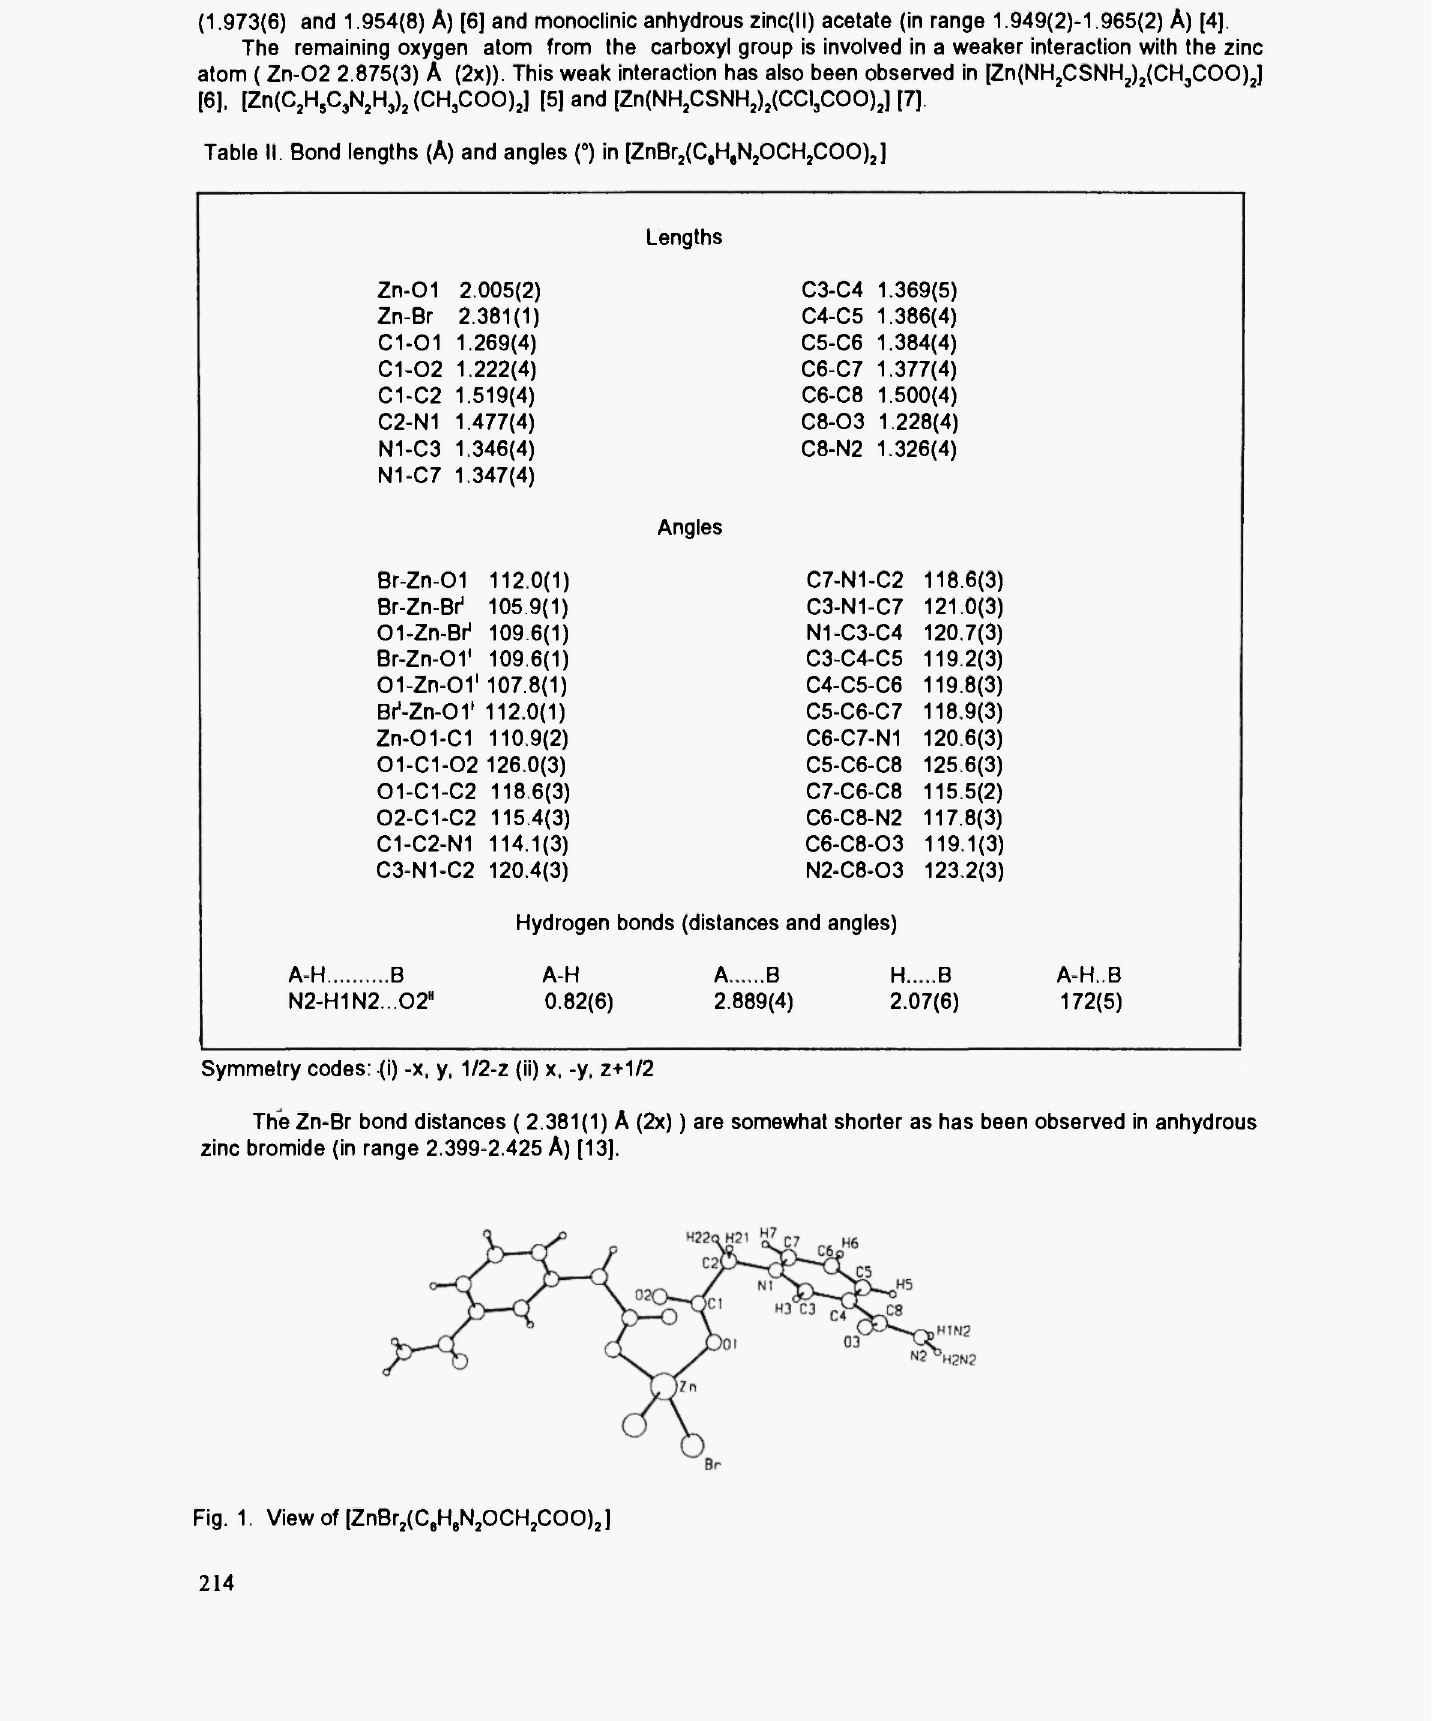
Table II. Bond lengths (A) and angles (°) in [ZnBr 2 (C,H,N 2 OCH 2 COO) 2 ]